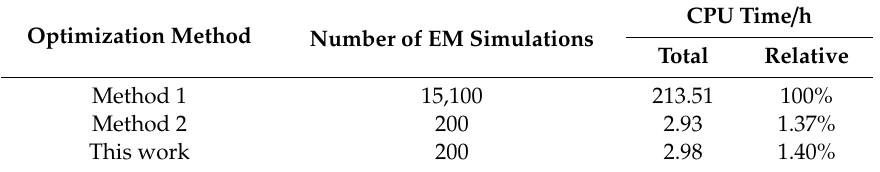
Table 4. Comparison of computational cost among different antenna optimization methods.